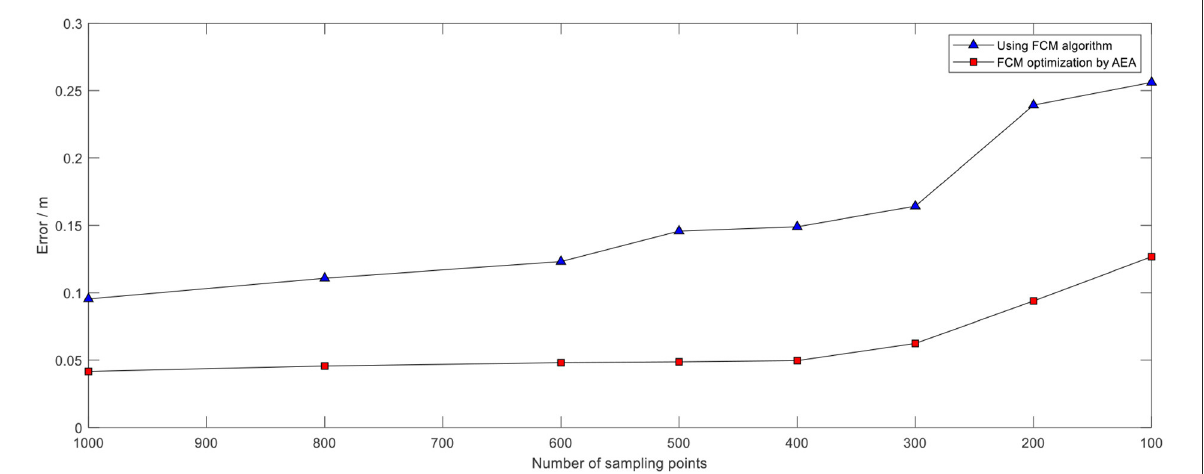
FIGURE15 Comparison of errors under the two algorithms under different sampling points.